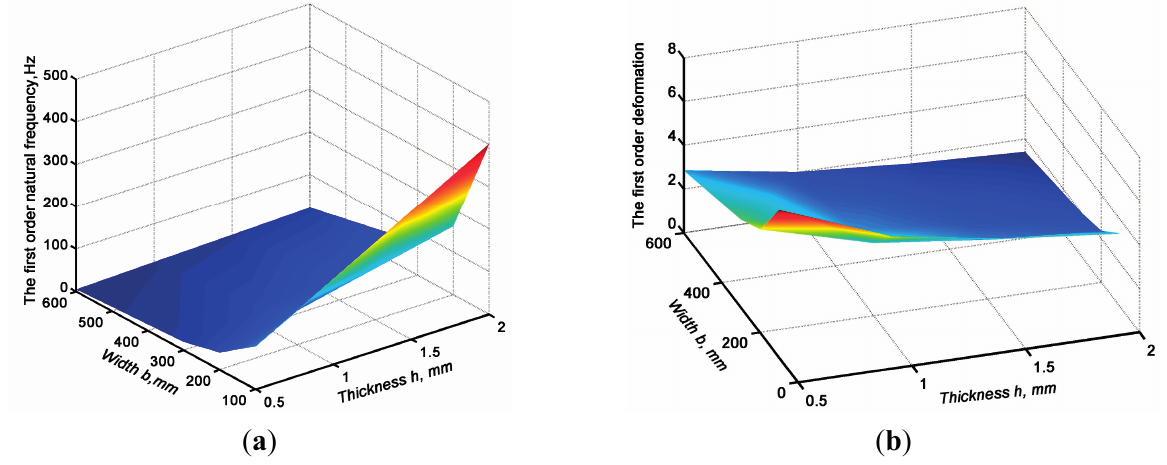
Figure 8. Effect of structure on the first order natural frequency and relative deformation ratio. ( a ) effect of width and thickness on the first natural frequency; ( b ) effect of